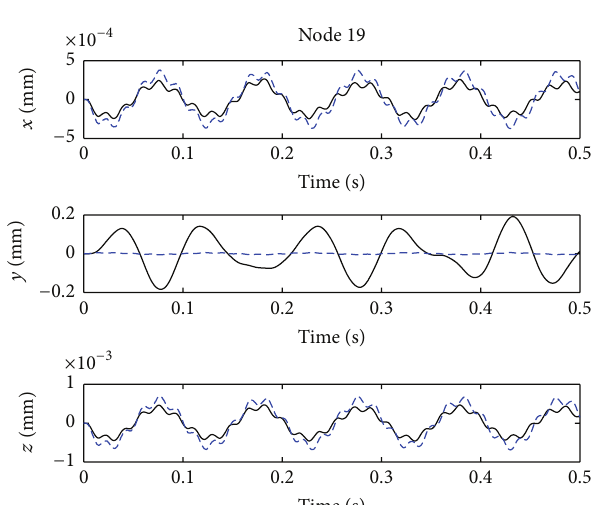
Figure 11: Output estimation error with (d).